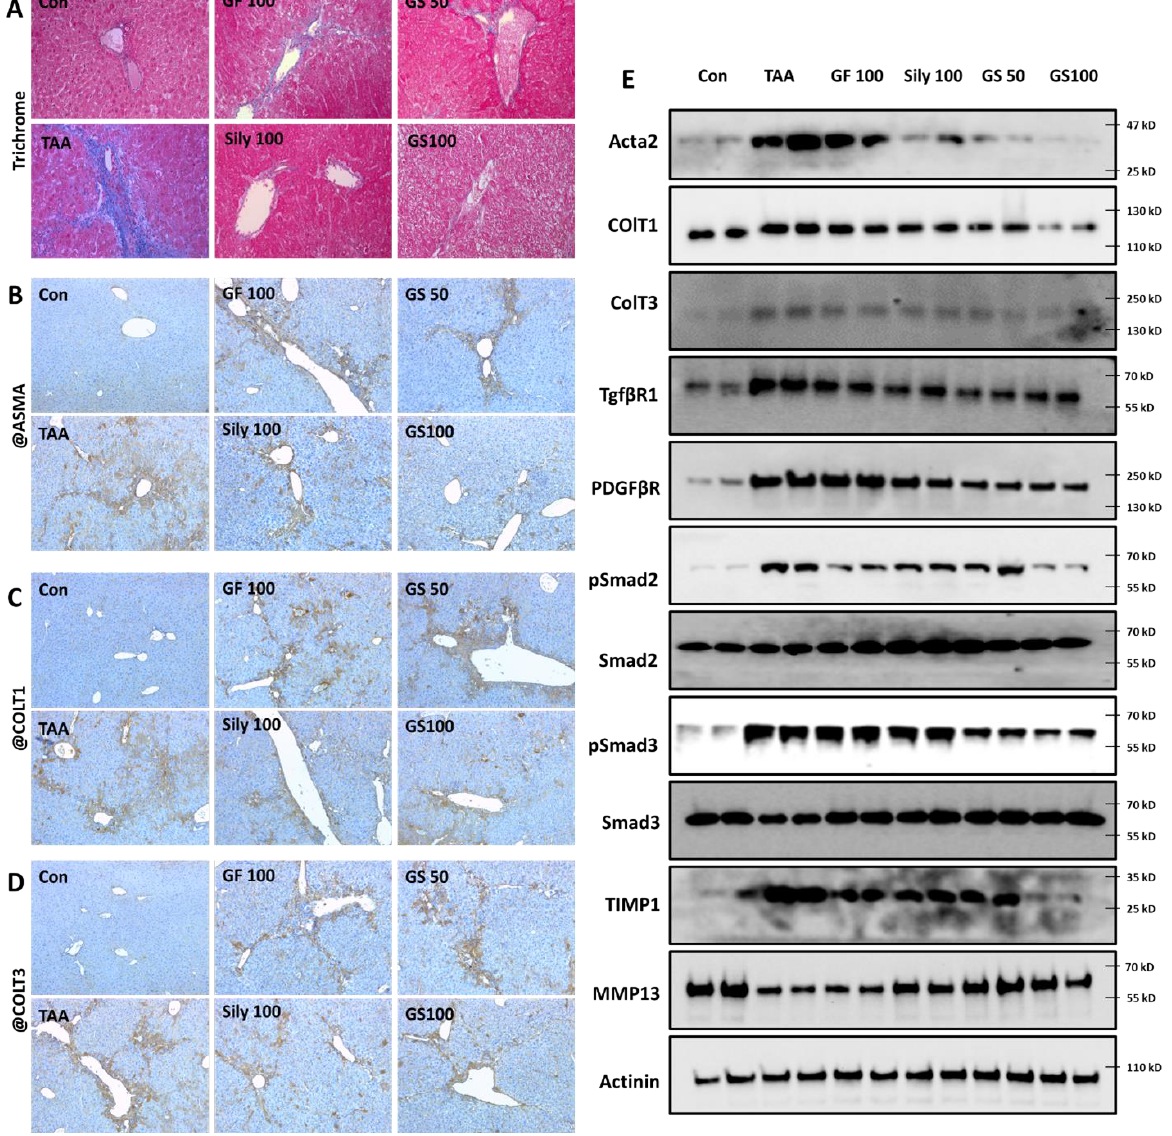
Figure 5. Anti-liver fibrosis effects of GS via attenuation of ECM production and pro-fibrogenic molecules. ( A ) Trichrome staining. IHC analysis against ( B ) ASMA, ( C ) ColT1 (collagen type1), and ( D ) ColT3 (collagen type3). ( E ) Western blot analysis of ECM production proteins and fibrogenic cytokine-related proteins ( n = 4 for trichrome and IHC analysis, n = 4 for Western blot analysis). Images were captured by light microscopy conditions (200× for trichrome staining and 100× for IHC analysis).